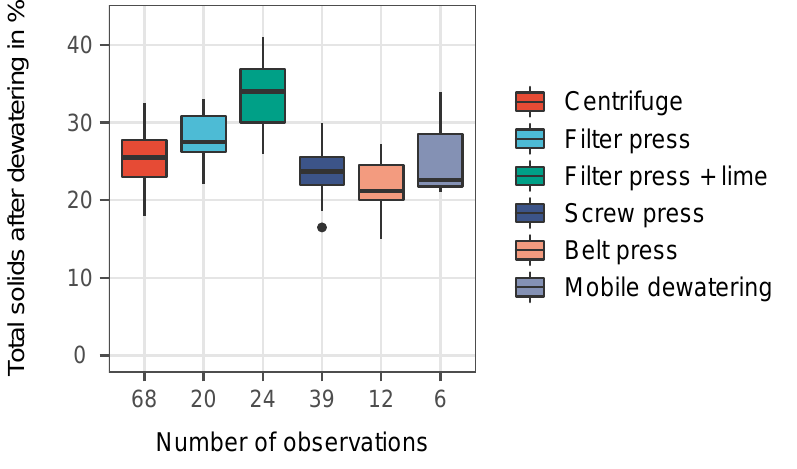
Figure 4. Dry matter content of dewatered sludge in percent according to the type of dewatering unit used and the (non-)addition of lime. Statistical values are provided in Table